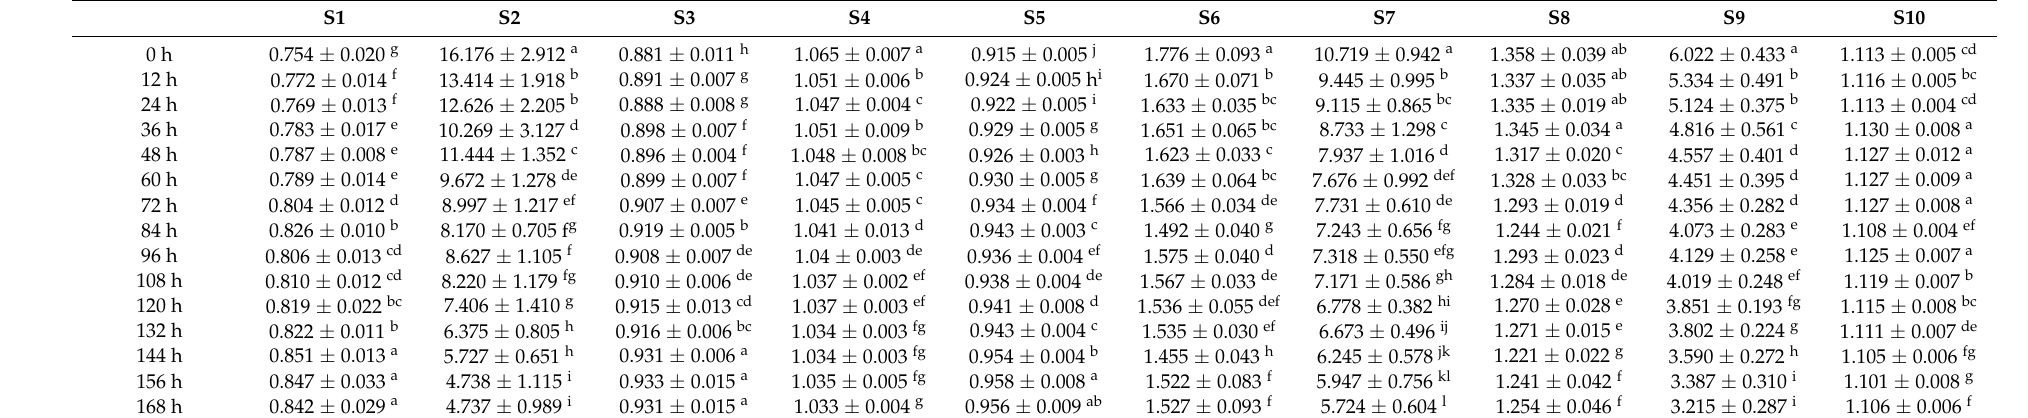
Table 3. ANOVA of the response values in E-nose of freshly squeezed strawberry juice during cold storage.